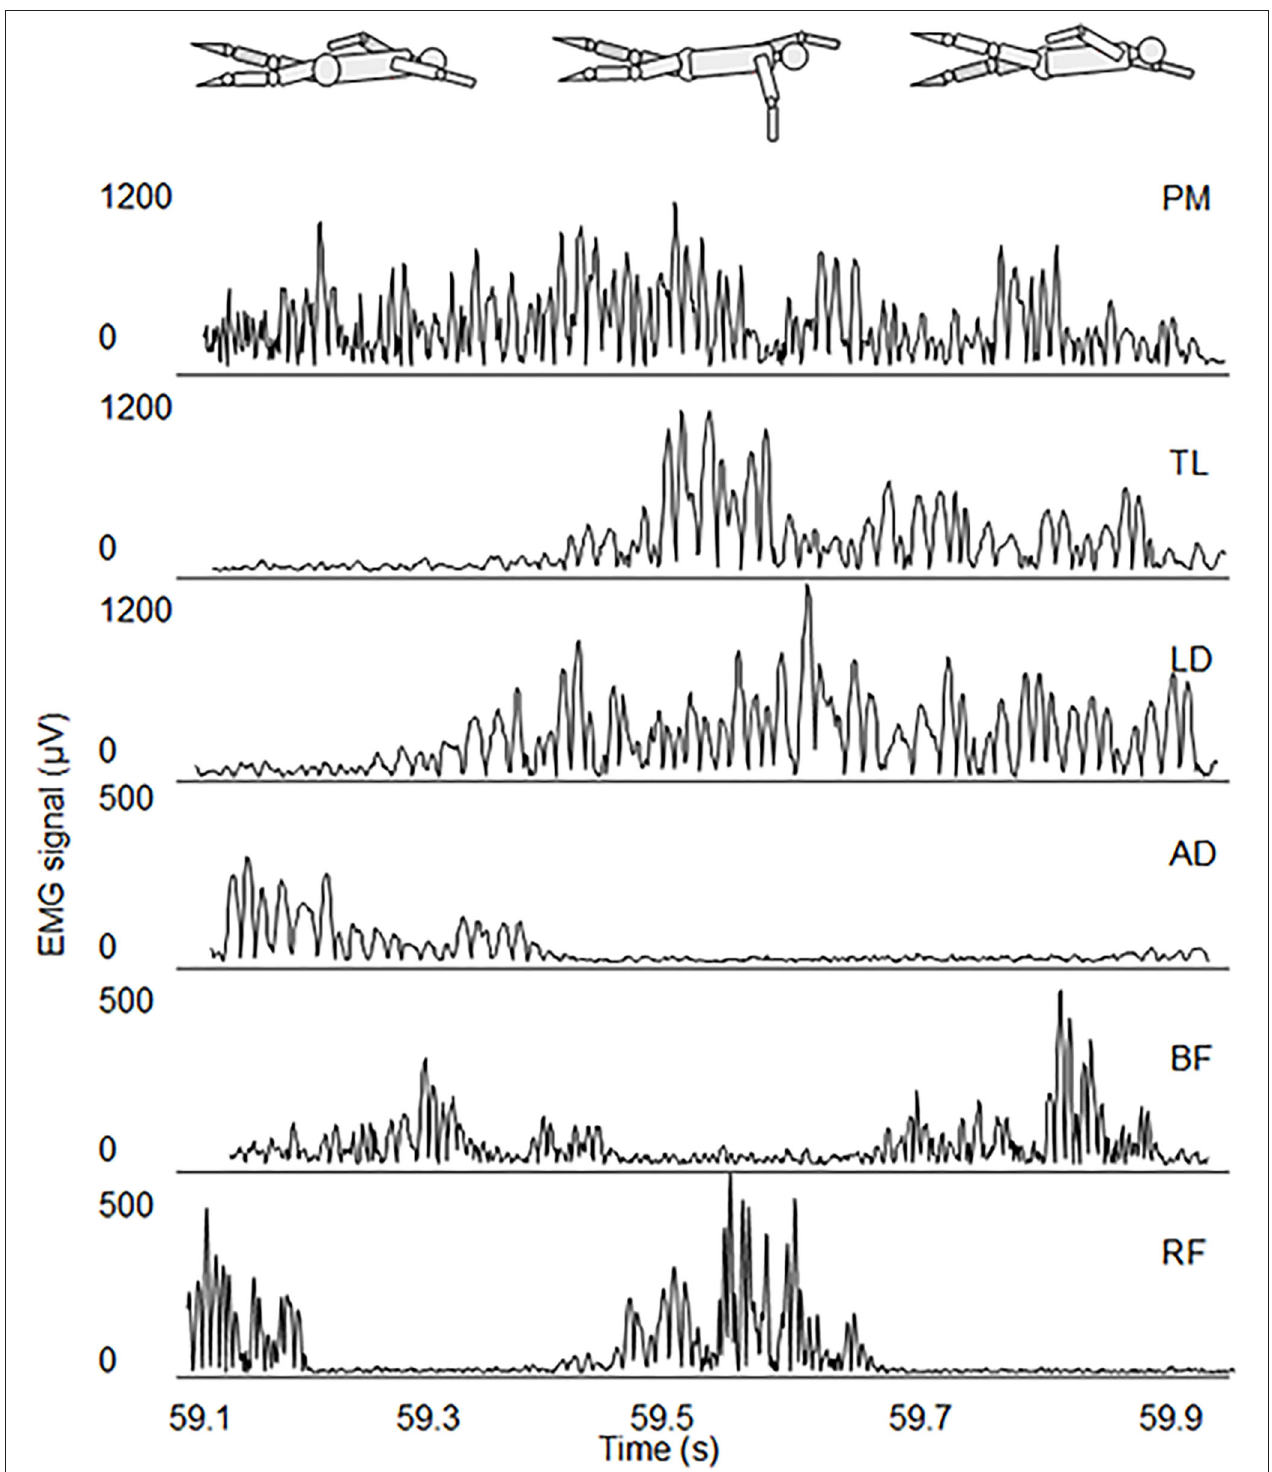
FIGURE 2 | EMG activation of the underwater phase stroke of the 6 muscles of one representative participant during the SFT.